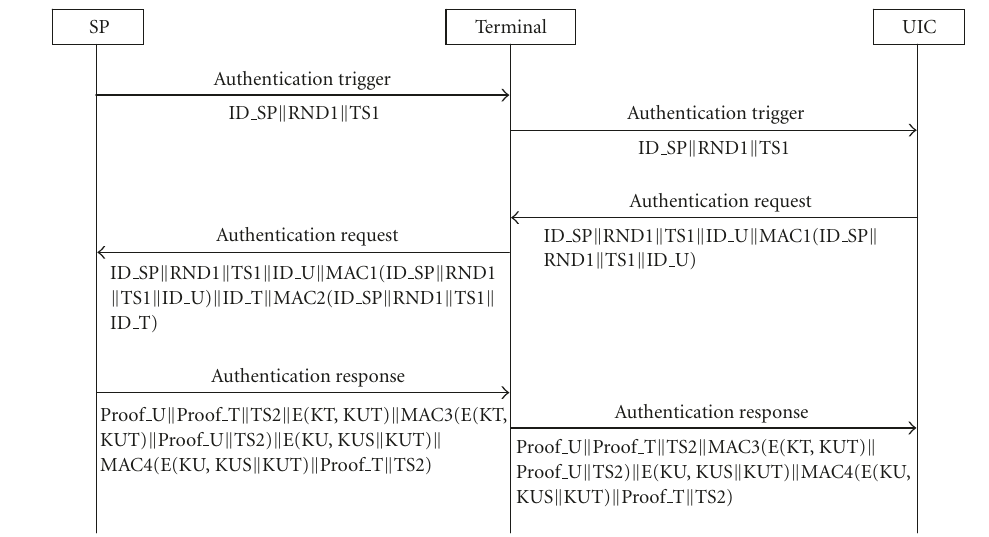
Figure 3: Proposed authentication protocol based on symmetric key